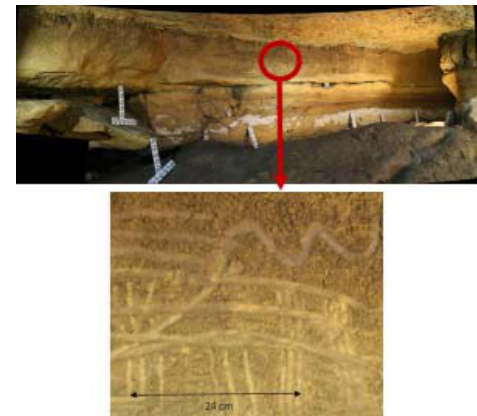
Figure 4. Panoramas and zoom on details of parietal art features requiring very accurate recording (object pixel size is less than 0.5mm)